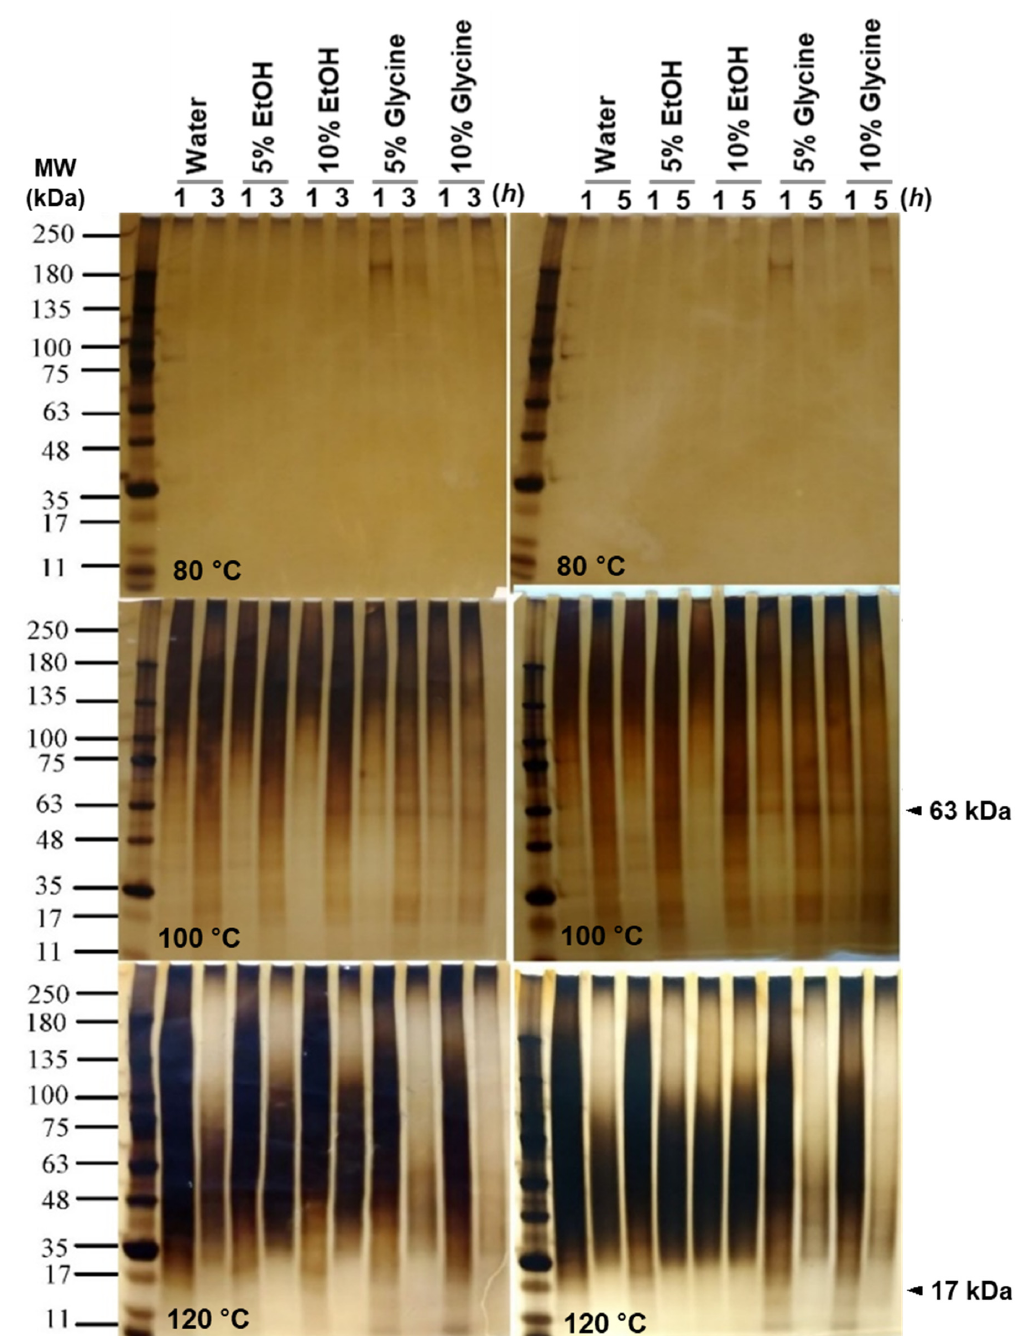
Figure 2. SDS-PAGE of SS protein under various extracting conditions. SS was extracted with various ingredients (water, 5–10% EtOH, and 5–10% glycine), temperature (80–120 °C) and time (1–5 h). A 4–20% gradient SDS-PAGE gel (Bio-Rad) was used.